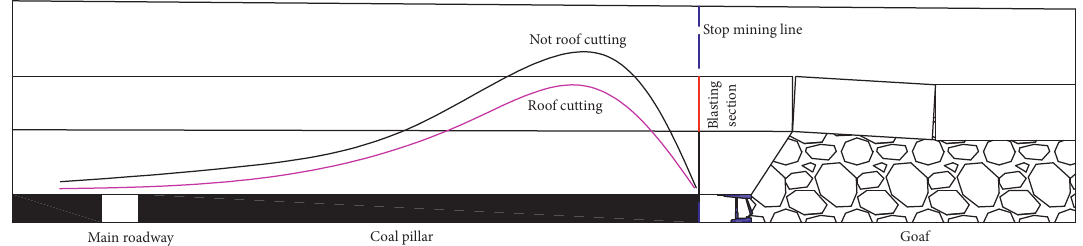
Figure 7: Abutment pressure distribution before and after roof-cutting.